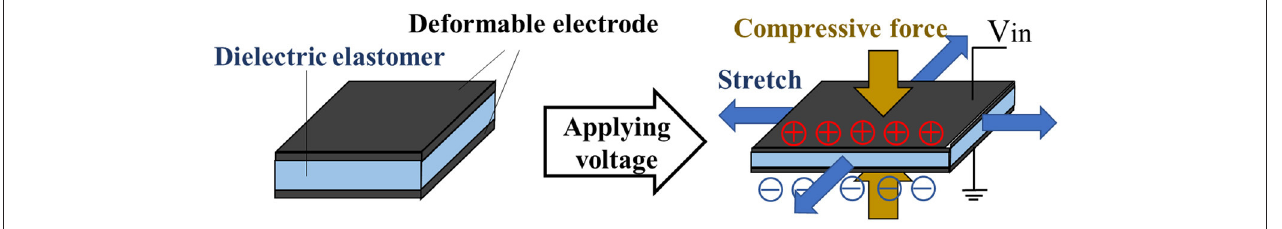
FIGURE 2 | Structure and principle of DEA. When voltage is applied to the elastomer having deformable electrodes attached to both sides, it extends in the horizontal direction.